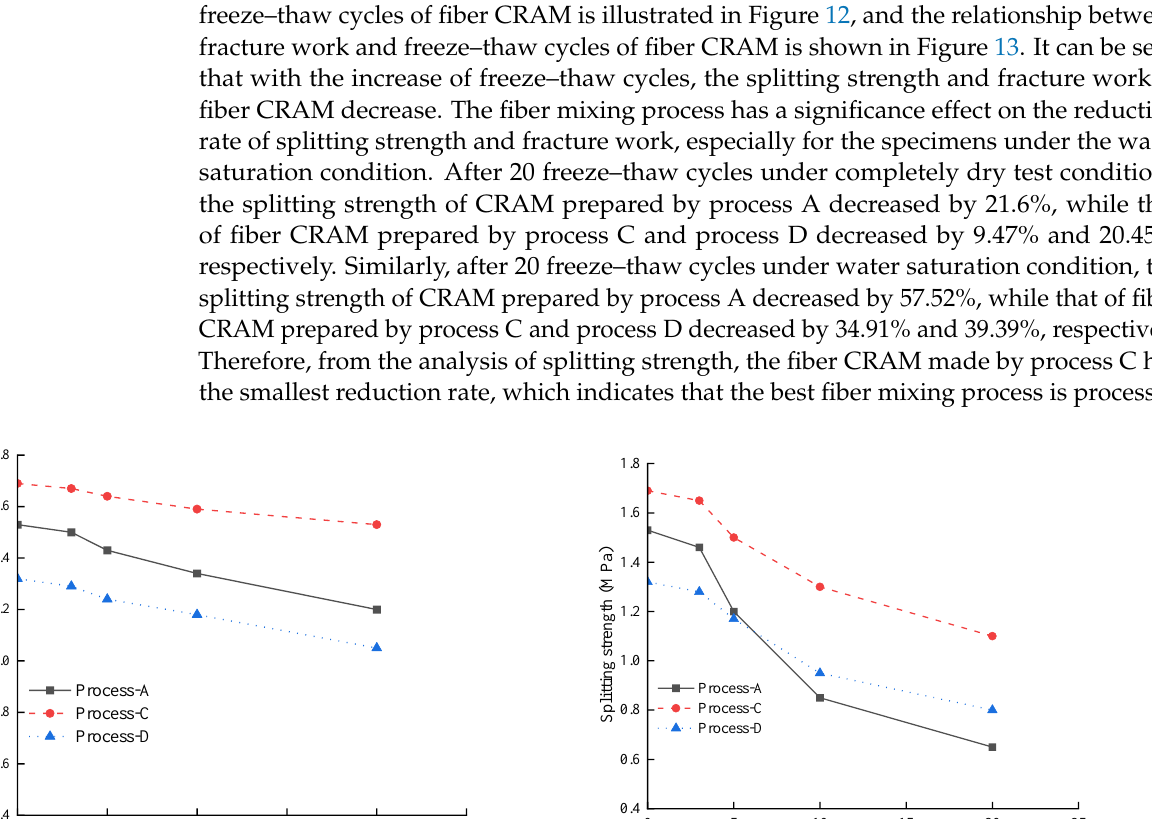
( b ) Figure 13. Relationship between fracture work and freeze – thaw cycles: (a) completely dry condition; (b) water saturation condition.